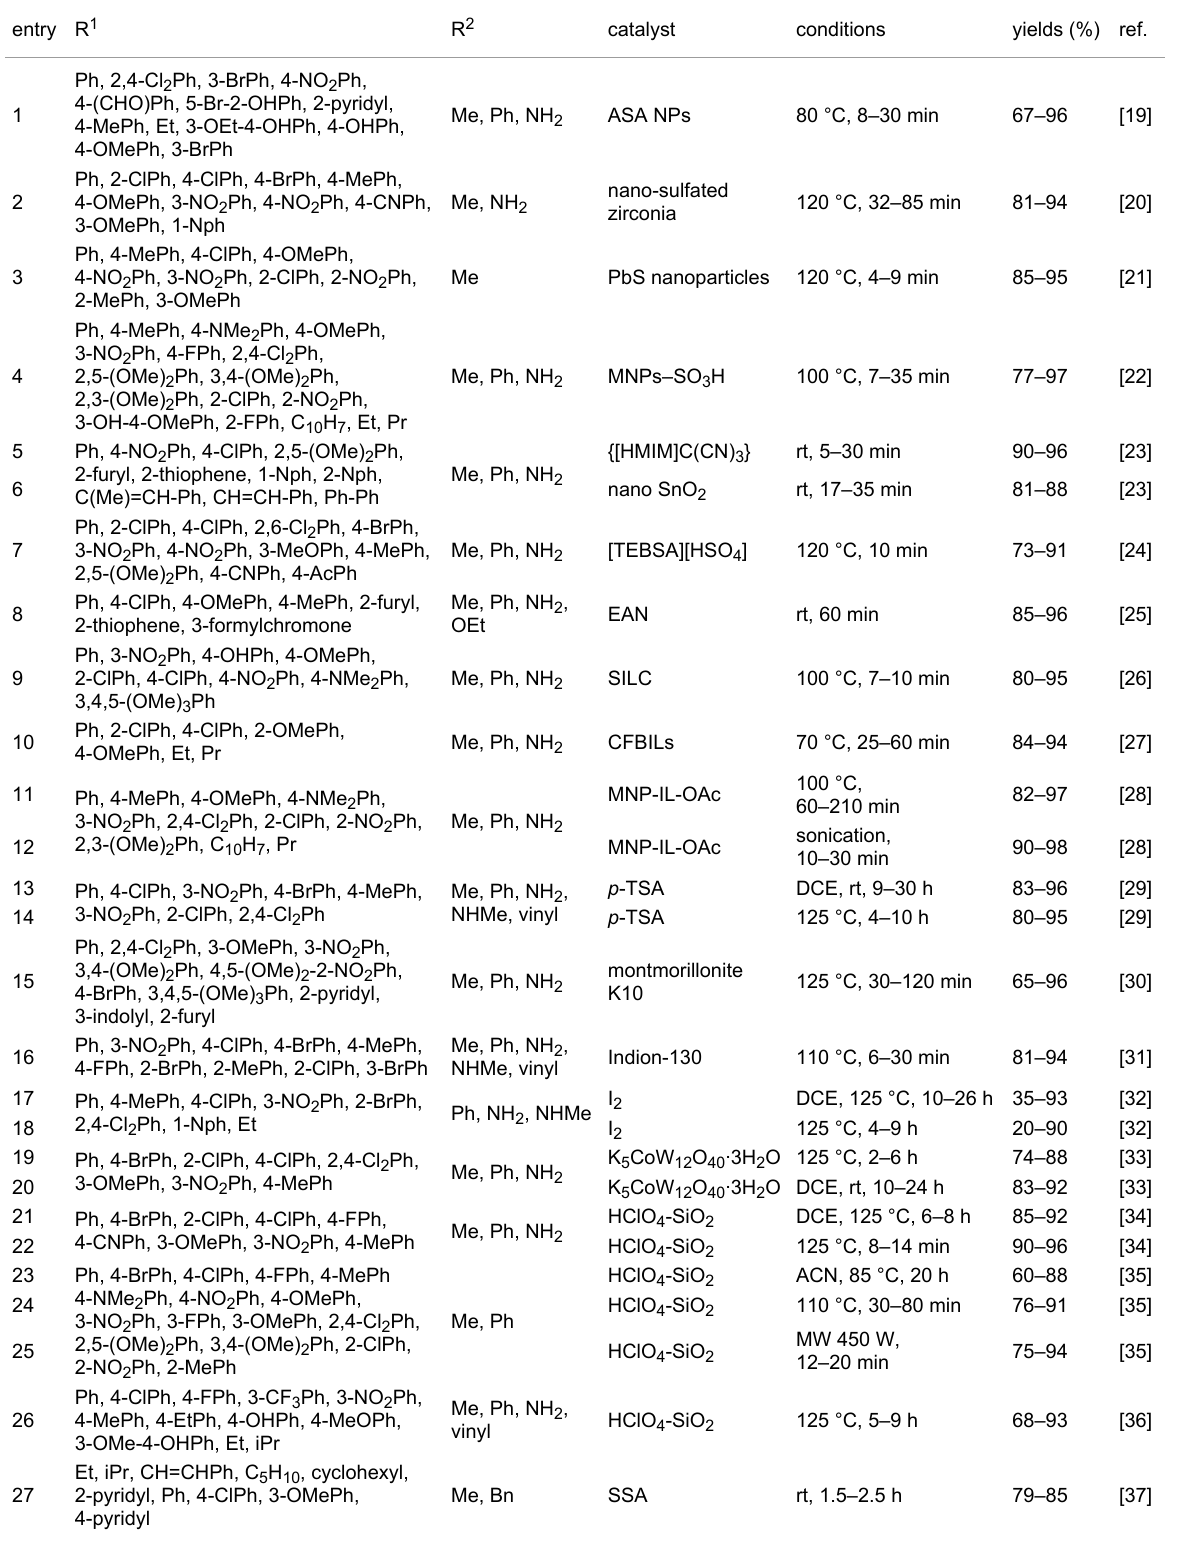
Table 1: Comparison of various conditions applied in the synthesis of amidoalkylnaphthols 4 .